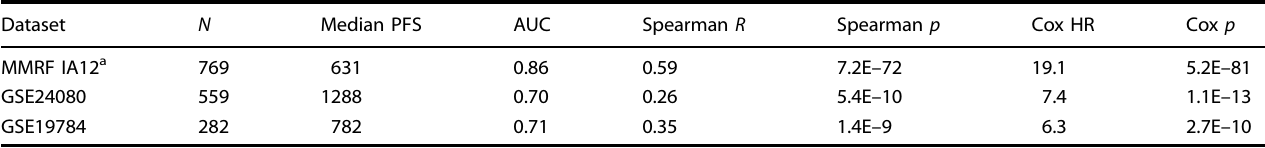
Table 1. Results of Ridge regression using regulon activity as